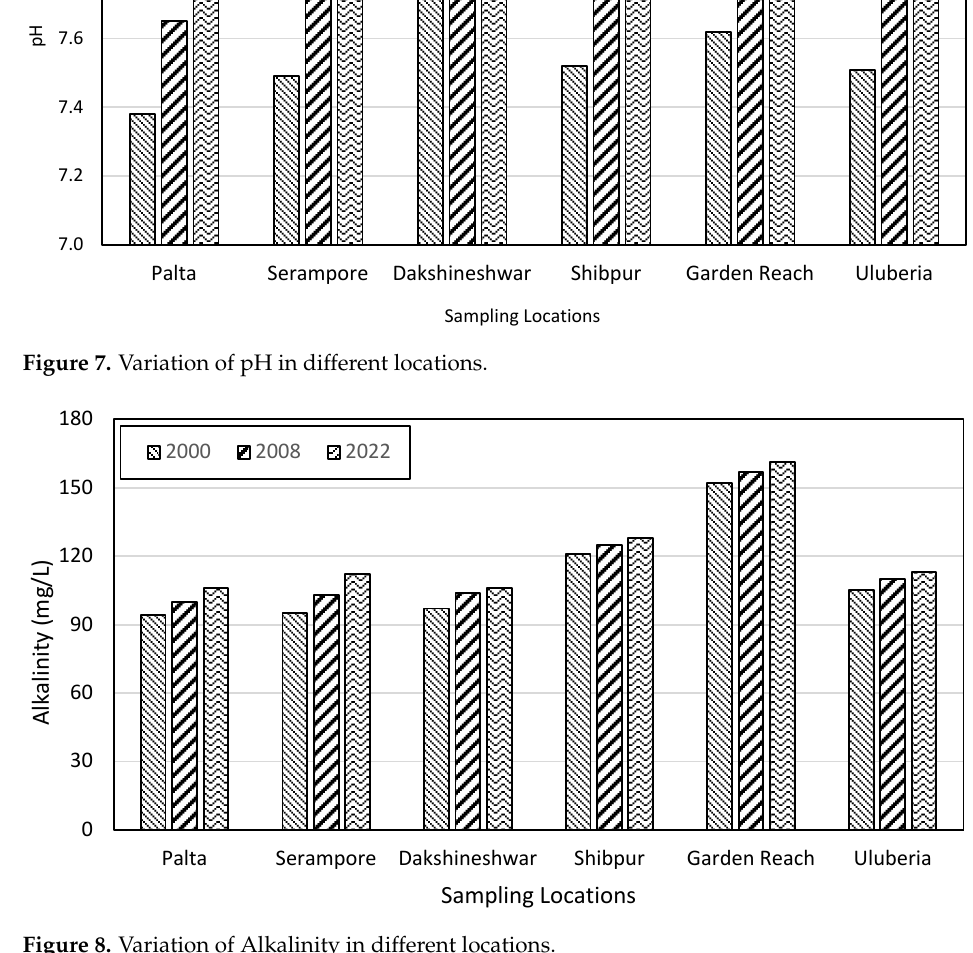
Figure 8. Variation of Alkalinity in different locations.